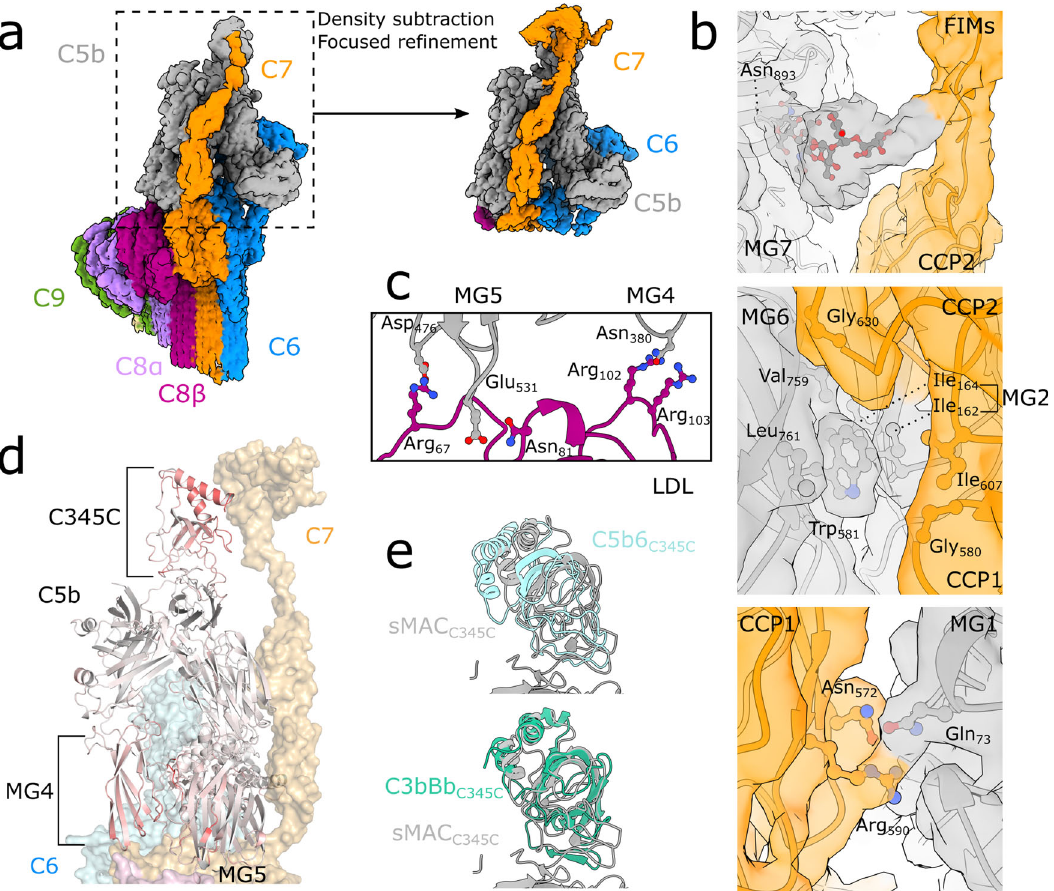
Fig. 3 C7 connects conformational changes of the C345C domain with the MG scaffold of C5b. a CryoEM reconstruction of 2C9-sMAC highlighting the region used in subsequent focused re fi nements (black-dotted lines). Inset corresponds to the map resulting from density subtraction of the MACPF-arc and focused re fi nement on C5b. Density is colored by protein composition. b Panels show density from the focused re fi ned map (colored by protein composition) overlaid with the sMAC atomic model (ribbons) at three interaction interfaces between C7 (orange) and C5b (gray). Glycan extending from C5b:Asn 893 stabilizes a linker between the C-terminal CCP and fi rst FIM domain of C7 (top). C5b:Tryp 581 locks into a hydrophobic hinge between the CCP1 and CCP2 domains of C7 (middle). Ionic interactions between the fi rst CCP of C7 and the MG1 domain of C5b (bottom). Side-chains of interface residues shown as sticks. c Interface between the C8 β LDL domain (purple) and C5b MG scaffold (MG4 and MG5 in grey). Side-chains of interface residues are shown as sticks. d C5b within sMAC (ribbons) colored by RMSD with superposed C5b from the C5b6 crystal structure (PDB ID: 4A5W). Red indicates residues with maximal differences. C345C, MG4 and MG5 domains of C5b are highlighted. C6 (blue), C8 (pink) and C7 (orange) are shown as semi- transparent surfaces for reference. e Superposition of C5b within sMAC (grey) with corresponding residues in the soluble C5b6 complex (cyan) (PDB ID: 4A5W) showing movement of the C345C domain (top panel). Superposition of C5b from sMAC (grey) with the structural homolog C3b (green) from